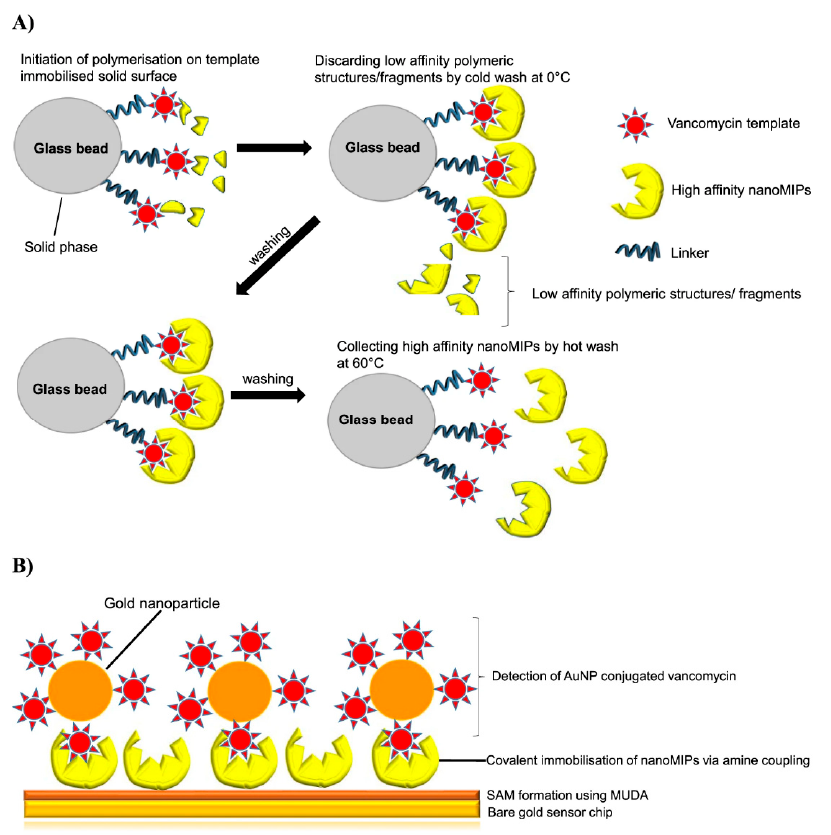
Figure 7. ( A ) Scheme of the preparation of vancomycin nanoMIP. ( B ) Scheme of the nanoMIP immobilization on the gold surface of the SPR chip. (Reproduced with permission from [69], open access Creative Common CC licensed 4.0, Springer